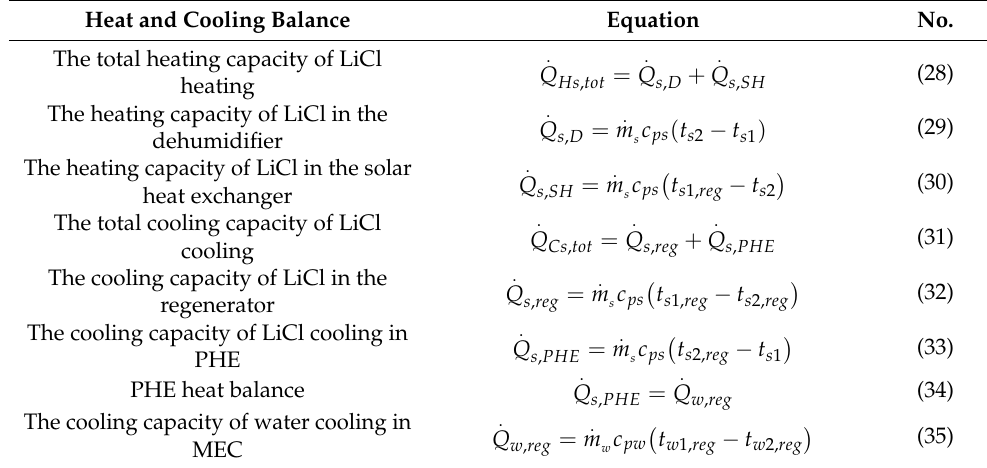
Table 5. Heat and cooling balance of the LiCl